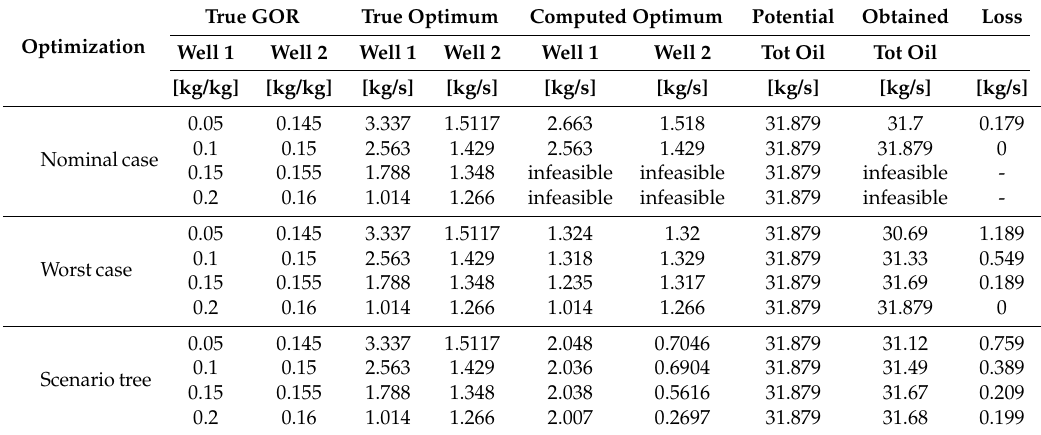
Table 3. Results–loss evaluations for the different scenarios for nominal, worst case and scenario-based